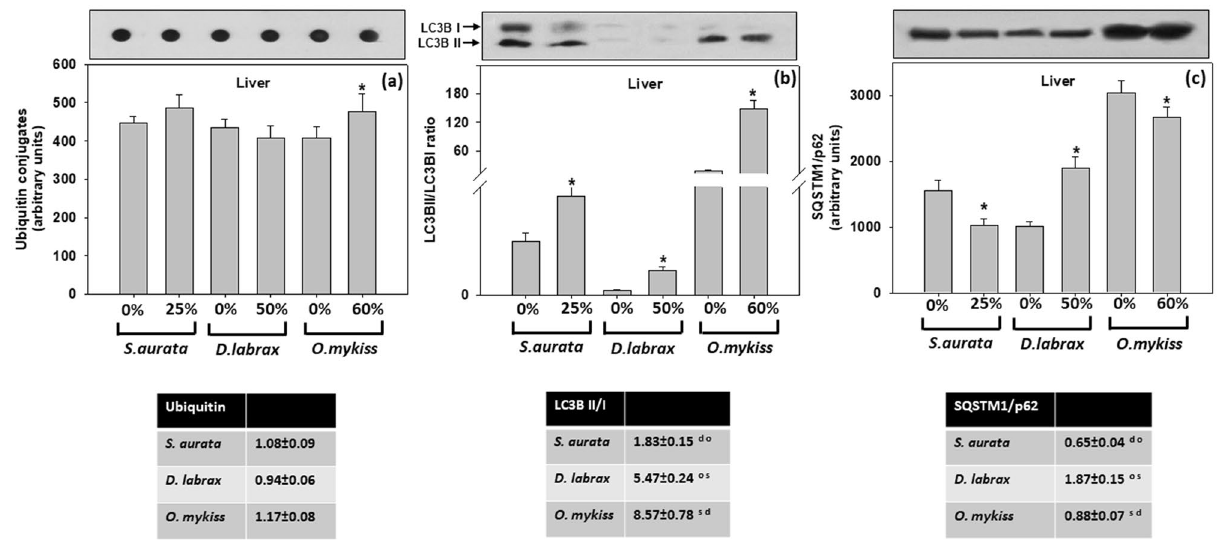
Figure 4. (a ) Ubiquitin conjugates, ( b ) LC3BII/LC3BI ratio and ( c ) SQSTM1/p62 in the liver of gilthead seabream ( Sparus aurata ), European seabass ( Dicentrarchus labrax ) and rainbow trout ( Oncorhynchus mykiss ) under the 0–25%, 0–50% and 0–60% respectively inclusion of T. molitor (TM) meal. Representative immunoblots (Western blot for LC3BII/LC3BI and SQSTM1/p62; Dot blot for ubiquitin cojuagates) are shown and were quantified by laser scanning densitometry [Gel-Pro Analyzer 4.0 software (Media Cybernetics, Inc. www. media cy. com)] and plotted [SigmaPlot 12.5 software (Systat Software Inc. www. systa tsoft ware. com)]. Values represent means ± SD; n = 5 preparations from different animals. Data was statistically analyzed [GraphPad Instat 3.10 (GraphPad Software, www. graph pad. com)]: *denotes significant differences ( p <